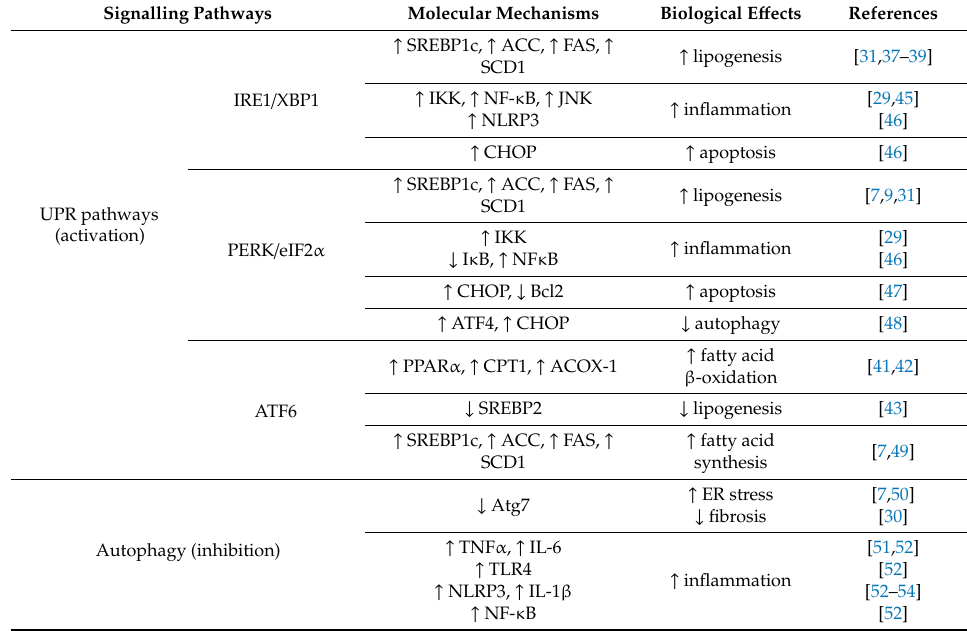
Table 2. Overview of unfolded protein response (UPR) and autophagy pathways in the pathogenesis of